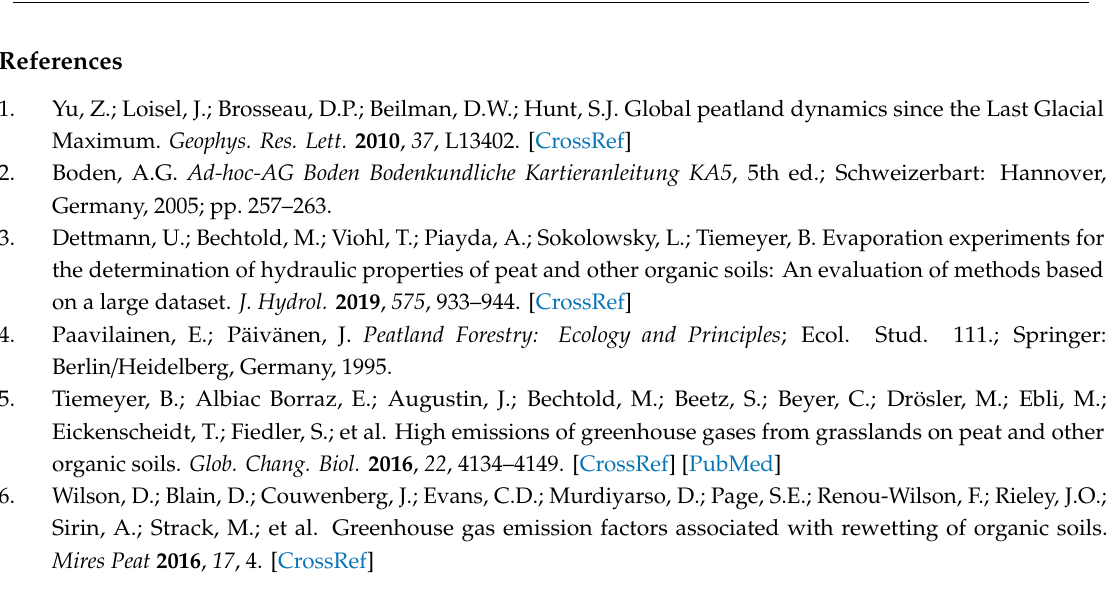
Figure S1: Boxplot of backscatter ( σ 0 (VV) constant: VV polarization normalized to a reference angle of 40 ◦ with a constant slope) for all 60 study sites and the entire study period shown for bins of water table depth (WTD) of 10 cm. The boxplot indicates a high and WTD-independent variability of absolute values of σ 0 .